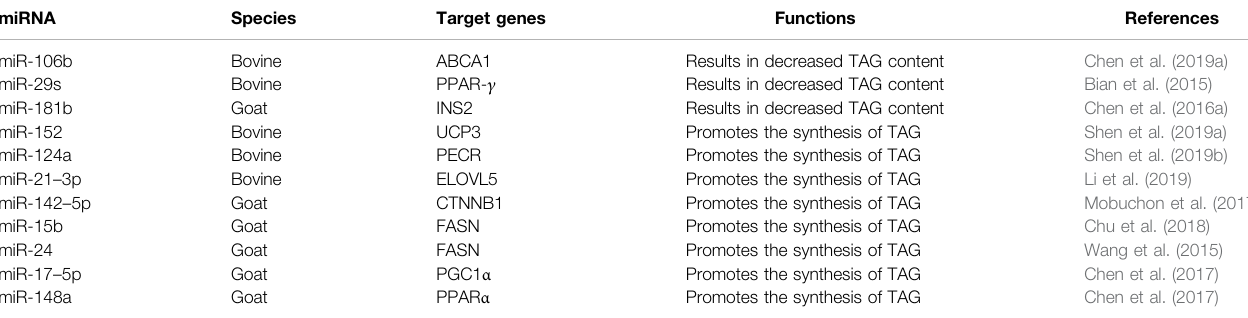
TABLE 1 | miRNAs involved in the regulation of TAG content in ruminant milk fat metabolism.